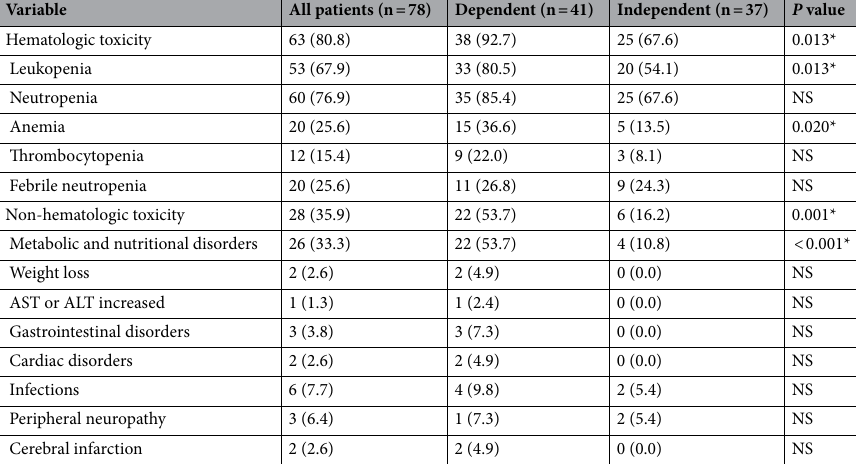
Table 4. Treatment-related adverse events (grades 3–4) in patients with DLBCL. AST aspartate transaminase, ALT alanine aminotransferase, DLBCL diffuse large B-cell lymphoma, NS not significant, *Comparison between dependent and independent; P value, Pearson’s chi-squared test or Fisher’s exact